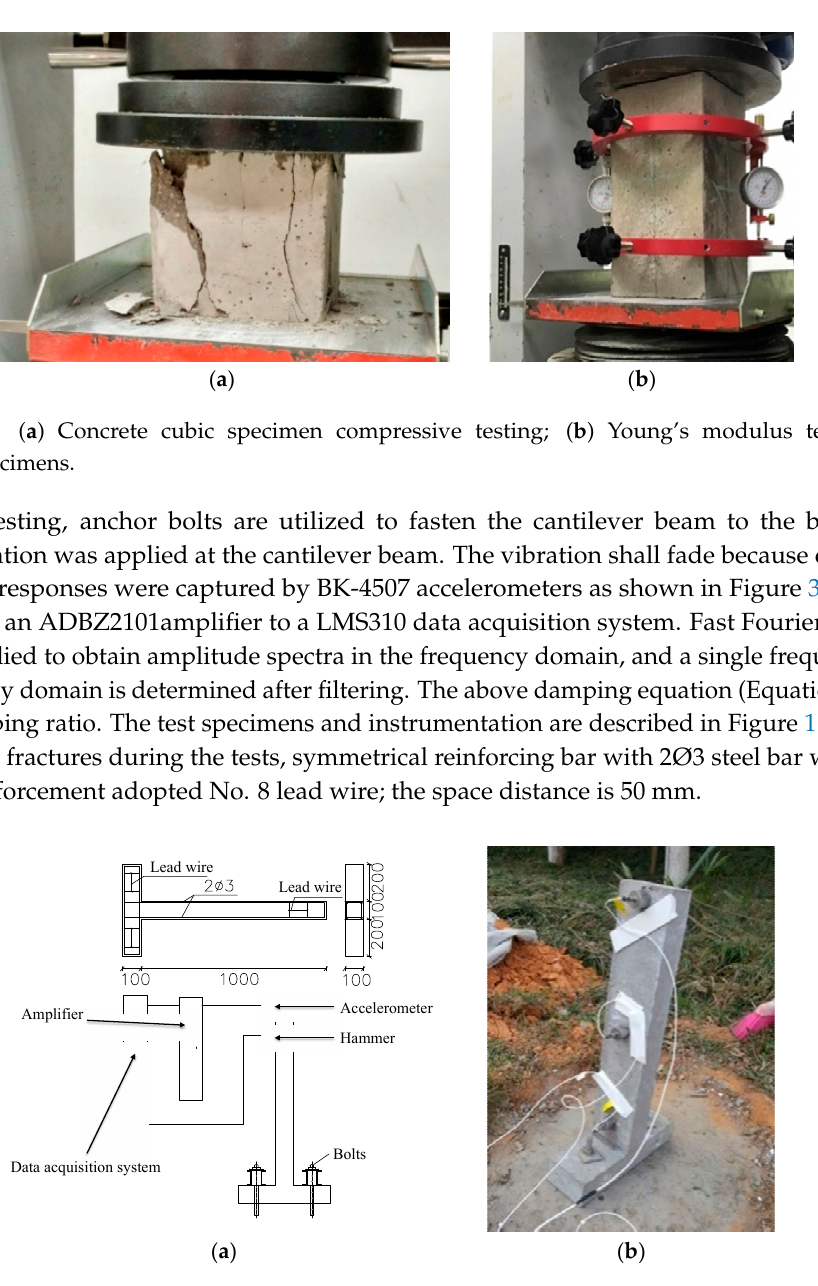
Figure 3. Damping ratio testing specimen and instrumentation for the rubber concrete: ( a ) Testing instrumentation diagram; ( b ) Testing instrumentation (mm).